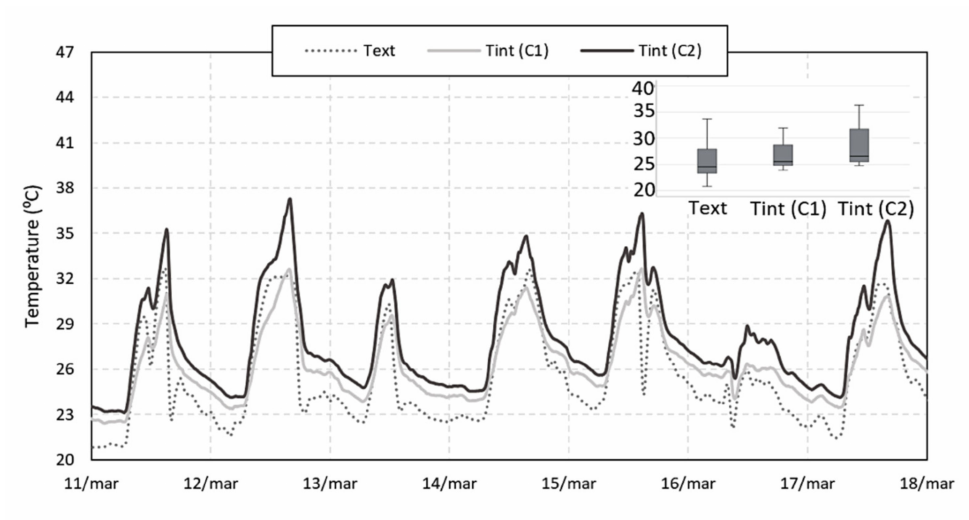
Figure 16. Variation of external and internal temperature in cells C1 and C2 during one week of campaign 6 (painting of the opaque envelope with reflective paint and natural cross ventilation by wind action during the night period).